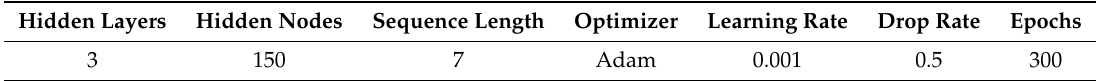
Table 4. Hyperparameters for the model